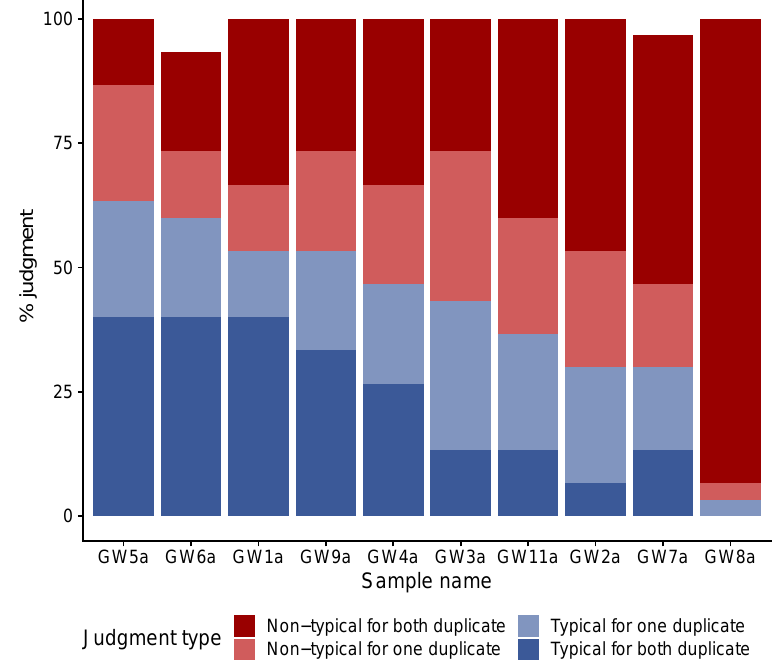
Figure 1. Results of the first step of the sensory analysis performed with the expert panel of 15 judges. Bar height represents the percentage of judgements for each category. Dark blue bars represent typical judgments for both duplicate of a sample, light-blue bars typical judgements for one of the two duplicate of a sample, light-red bars non-typical judgements for one of the two duplicate of a sample and dark-red bars non-typical judgements for both duplicate of a